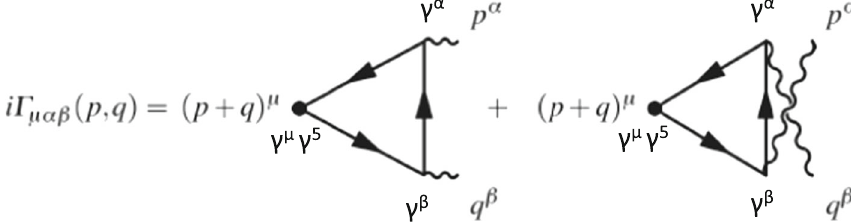
Fig. 1 Generic triangle anomaly diagrams, with one axial vector ( γ μ γ 5 ) and two vector ( γ α,β ) vertices. The wavy lines indicate external Abelian (or non-Abelian) gauge bosons